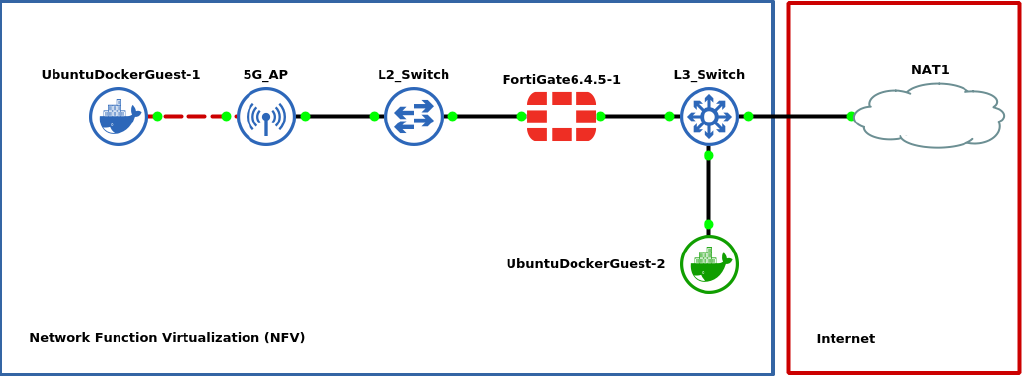
Figure 3. 5G network